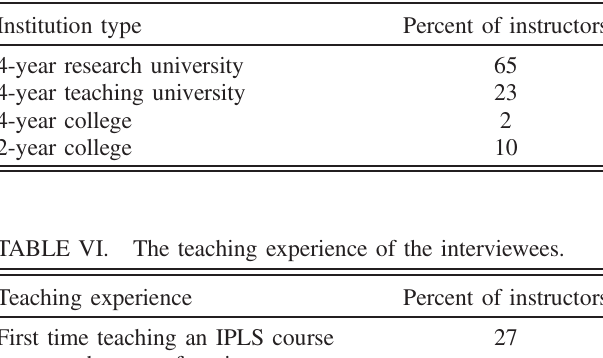
TABLE V. The affiliation of the interviewees ( N ¼ 35 ). Institution type